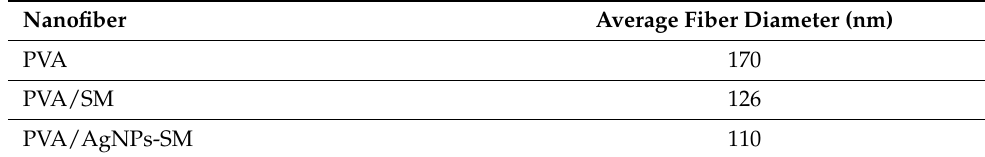
Figure 3. SEM images of PVA ( A , B ), PVA/SM ( C , D ), and PVA/AgNPs-SM nanofibers ( E , F ). Table 3. Average Fiber Diameter (nm) of the electrospun nanofibers.